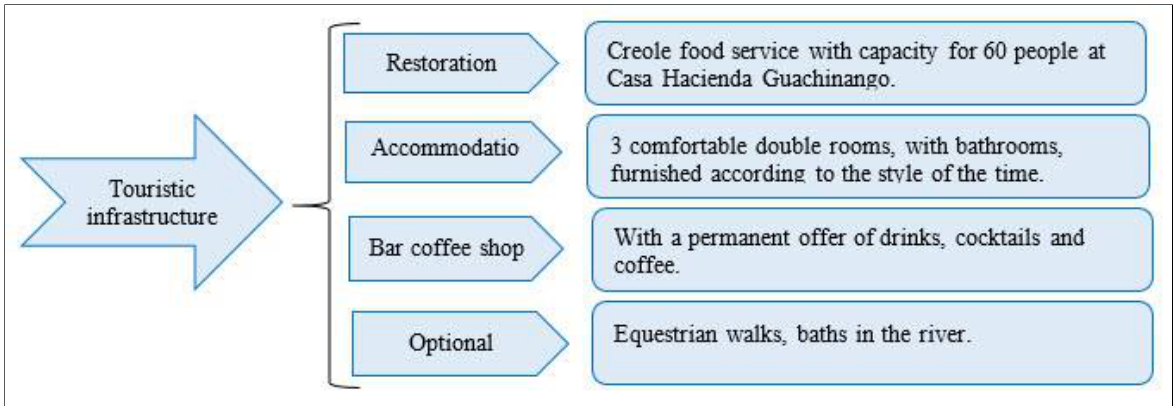
Figure 6. Infrastructure of basic services available for agrotourism in Hacienda Guachinango. Source: own elaboration based on the results of the inventory of resources in Hacienda Guach- inango. The application of the methods and techniques foreseen in the design of the Cuban tourism model was used to diagnose the product studied. Despite some difficulties de- tected in the resource inventory at Hacienda Guachinango, it can be seen that it has the necessary conditions for the development of agrotourism, which is corroborated by the